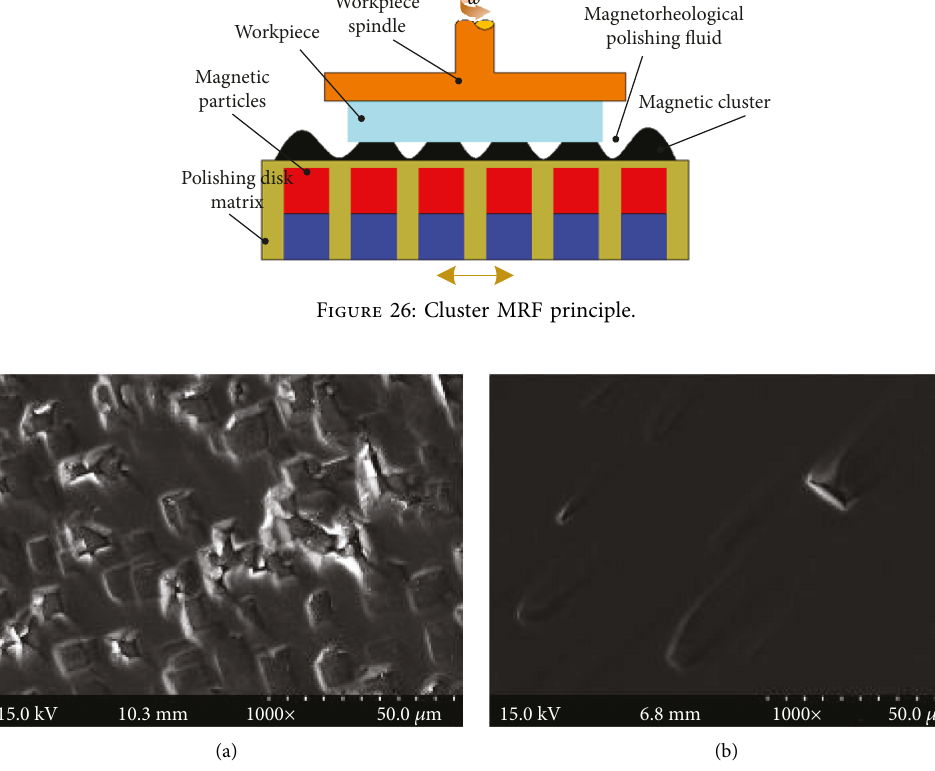
Figure 27: Surface morphology under different magnetic fields [152]. (a) Static magnetic field (68nm). (b) Dynamic magnetic field (16.2nm).